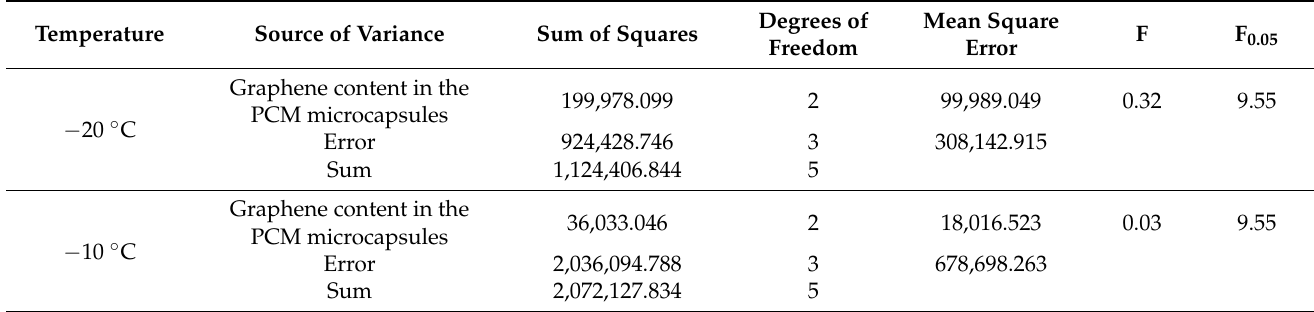
Table 5. Variance analysis of the fracture energy results in the performed SCB tests.